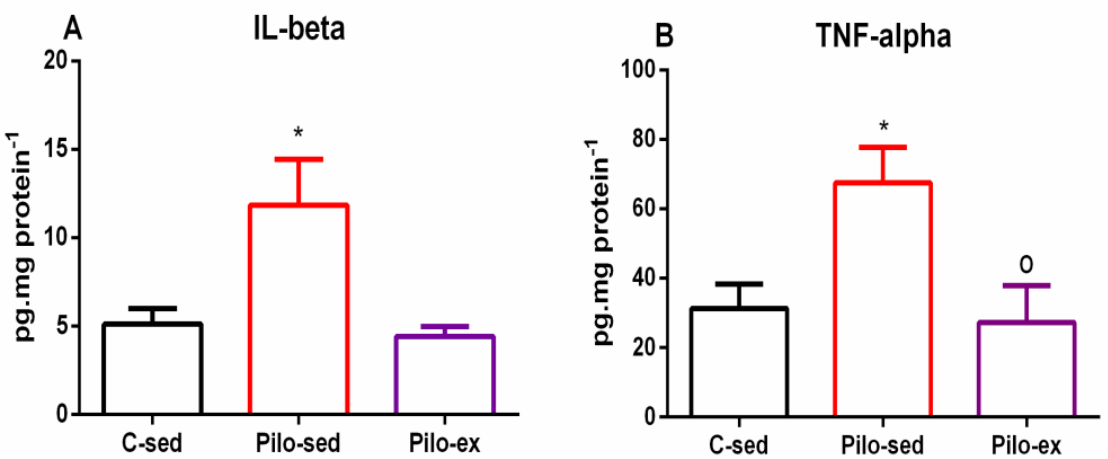
Figure 9. Effect of endurance training, applied before and after SE, on ( A ) pro-inflammatory cytokines IL-1 β levels, * p = 0.024 in comparison with the C-sed group, and ( B ) TNF- α , * p = 0.024 in comparison with the C-sed group and o p = 0.0334 in comparison with the Pilo-sed group, respectively, in the hippocampus.